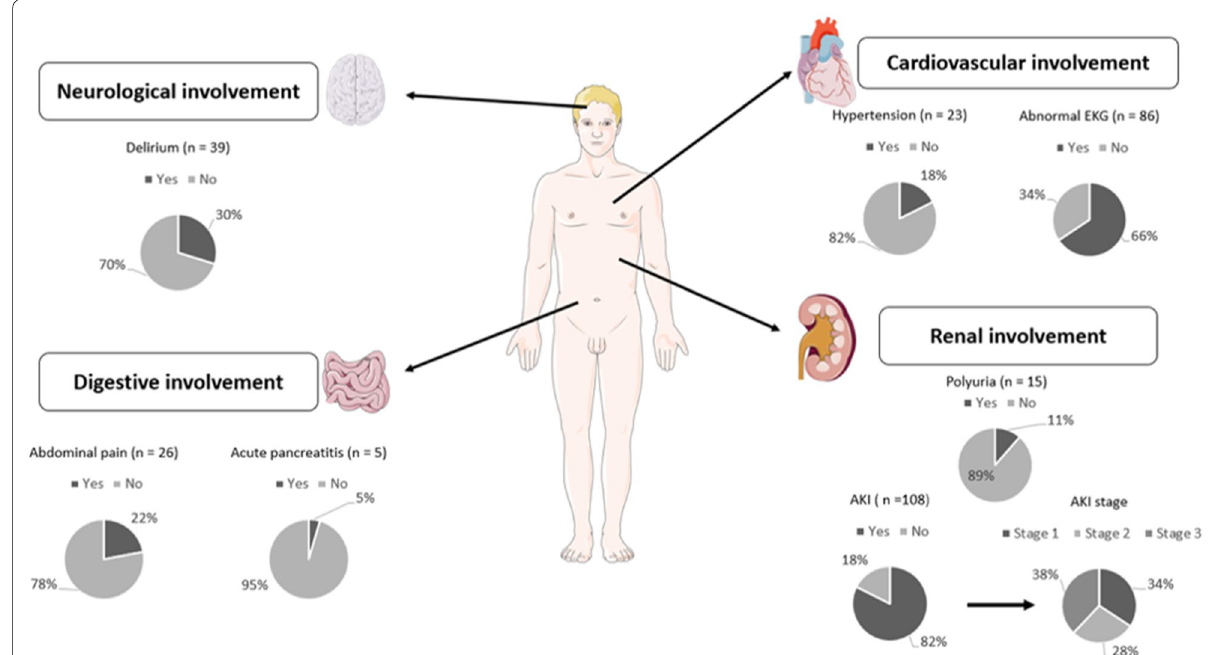
Fig. 1 Clinical manifestations of HCM. AKI acute kidney injury, AKI stage based on KDIGO guidelines, EKG